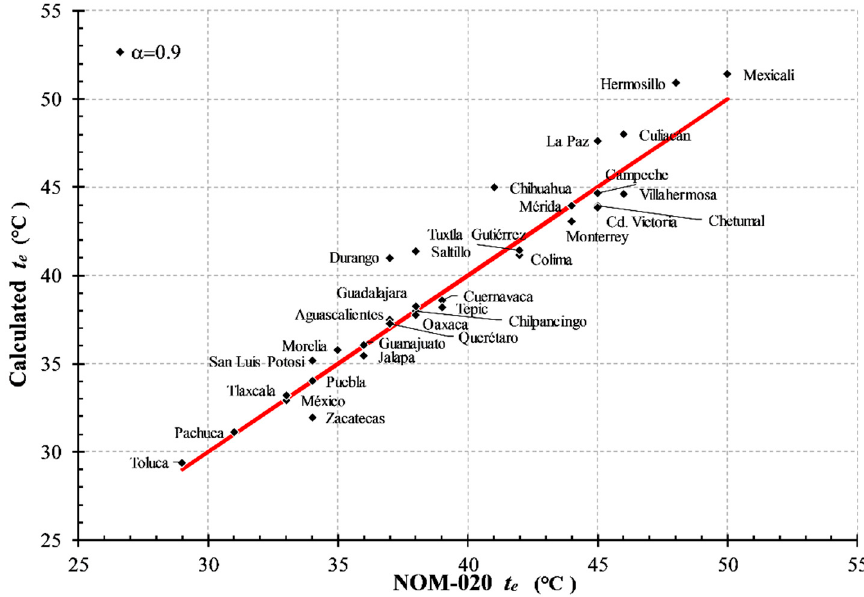
Figure 3. NOM-020-ENER-2011 ( t e ) (black squares) vs calculated ( t e ) (red line), α = 0.9.